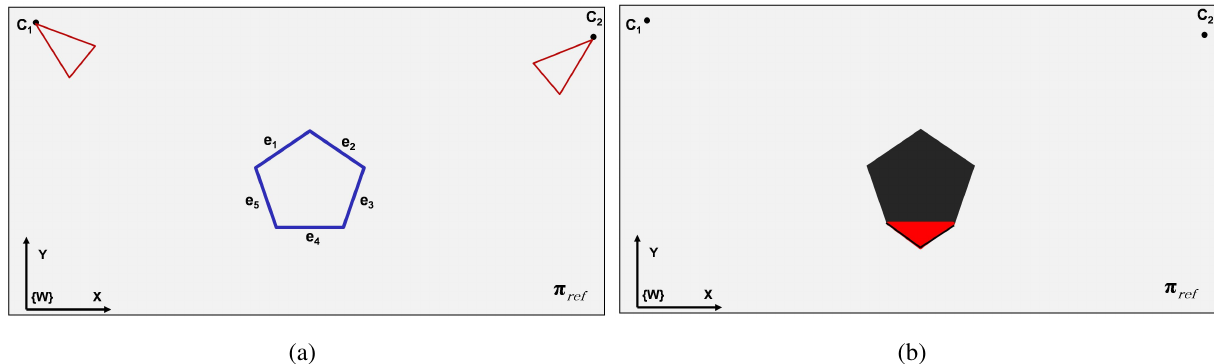
Figure 1. Investigation of the criteria for visibility of a general convex polygon. ( a ) An exemplary convex polygon is being observed by two cameras. The images are shown from the top view of the inertial reference plane π . ( b ) The registration of the polygon ref corresponding to left picture. The registration includes the object and some extra areas (coloured in red) which do not belong to the polygon. This red area has appeared because of not having visibility on the lowest edge of the polygon.